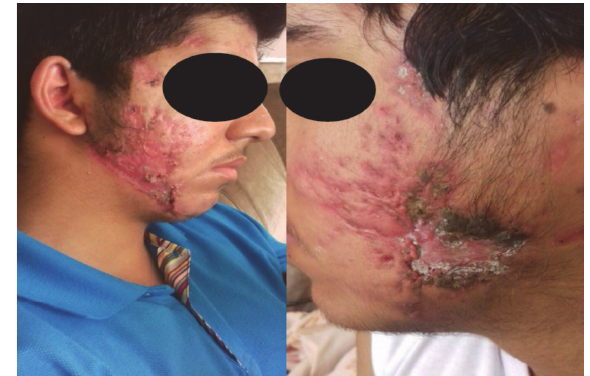
Figure 1: Acne fulminans. Hemorrhagic ulcerations with purulent crust scattered on both sides of the face.